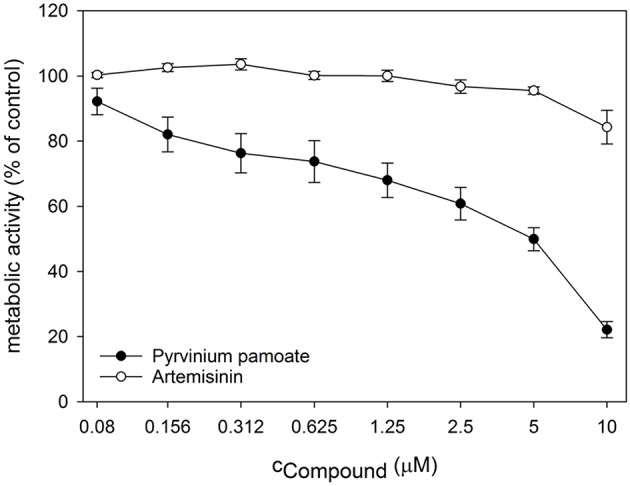
Cell cultures of A549 epithelial cells were treated with indicated concentrations of Artemisinin and Pyrvinium pamoate for 48 h. Metabolic activity was determined by CellTiterBlue assay. The values are the means ± SD of at least 3 independent experiments.